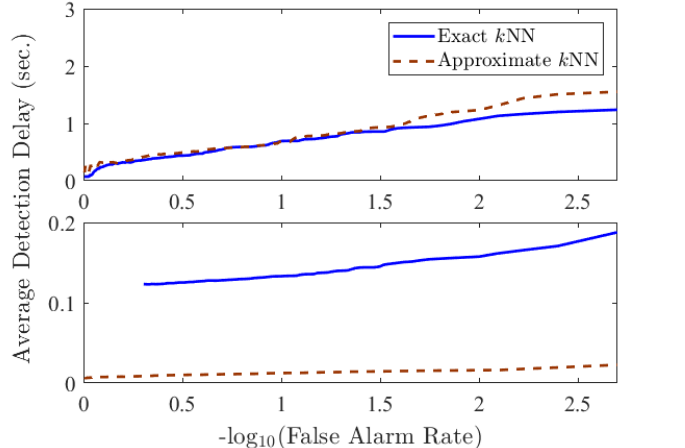
Figure 3. Comparison between performance of ODIT based on exact and approximate k NN distances in terms of seconds for T sampling = 1 s ( top ) and T sampling = 0.01 s ( bottom